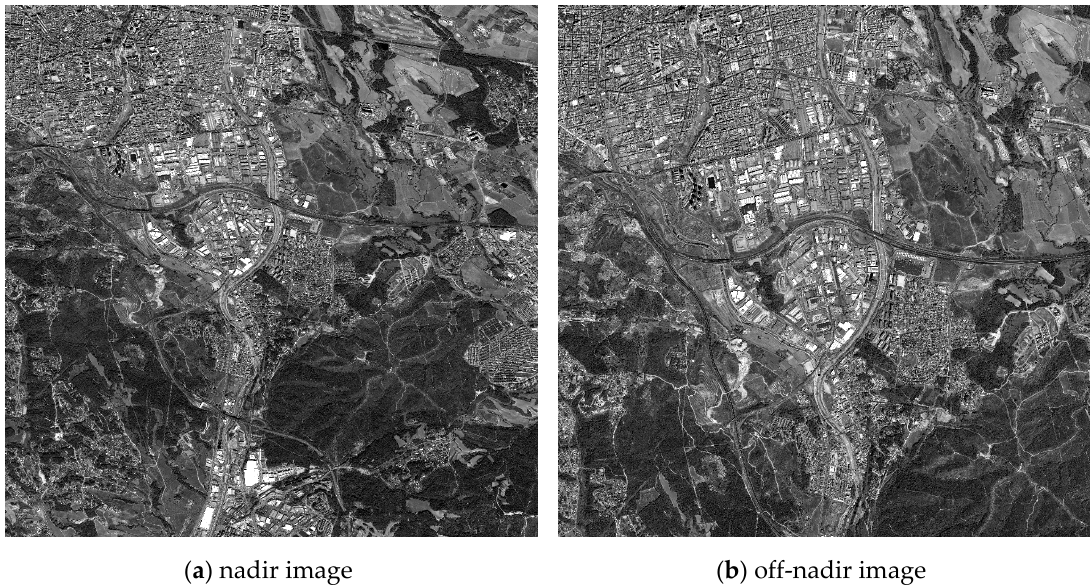
Figure 7. Stereo Worldview-1 images from August 2008.